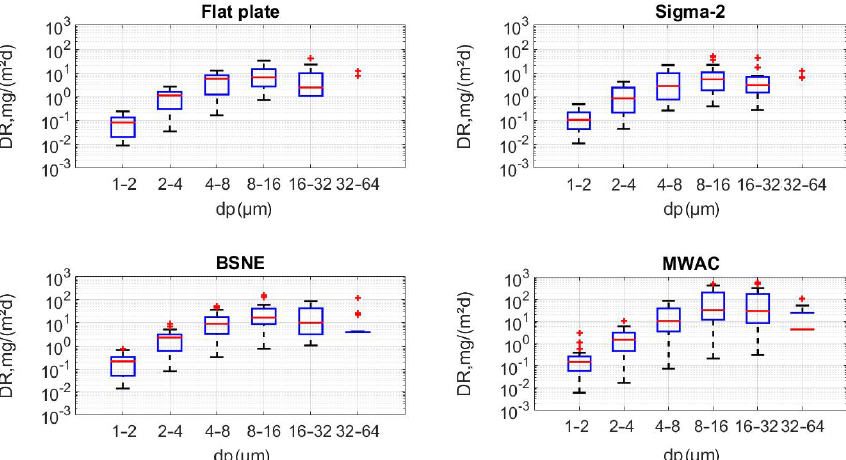
Figure 6. Box plots of size-resolved deposition rate (campaign data; flat-plate, Sigma-2, MWAC and BSNE samplers). On each blue box, the central mark is the median; the edges of the box are the 25th and 75th percentiles. The vertical red lines show the standard deviation. The median, percentiles and standard deviations shown there correspond to the variability of the whole campaign for each instrument and bin. From the structure of the deposition models, a wind speed dependency for the deposition velocity should be expected. The average wind speed during the campaign was about 3.5ms − 1 , with the lowest daily median around 1.5ms − 1 and the highest 7ms − 1 . A daily box plot of 30min averaged wind speed at Izaña is shown in Fig.